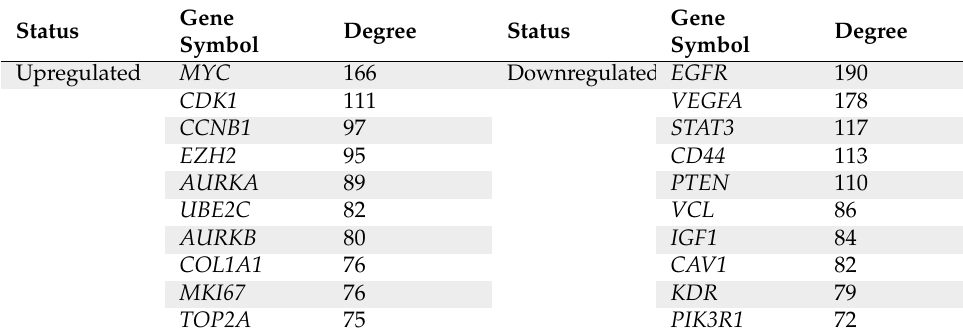
Figure 6. ( A ) Most significant upregulated and downregulated genes PPI network map. (upregulated genes represented by red colour and downregulated genes represented by blue colour) ( B ) Top 10 most connected upregulated and downregulated genes according to their highest degree score associated with prostate cancer. (upregulated genes represented by red colour and downregulated genes represented by blue colour) ( C ) Top 10 hub significant genes extracted by PPI Cyto-hubba network & ( D ) Top 10 bottleneck significant genes excavated from PPI Cyto-hubba network. Higher score is represented by colour intensity in hub and bottleneck genes both. (upregulated genes represented by red colour and downregulated genes represented by blue colour) ( E ) Deep network extraction showing the key genes, TF and miRNA interaction with each other. (upregulated genes represented by red colour, downregulated genes represented by blue colour, miRNA represented by green colour & TFs represented by violet colour). Table 2. Top 10 highly connected up and downregulated